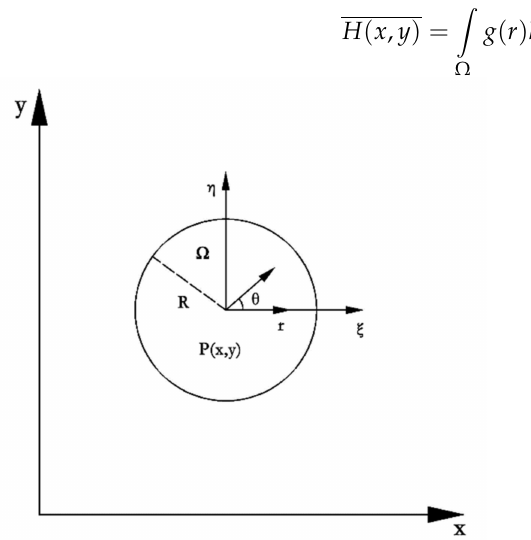
Figure 3. The area of influence at a point in the